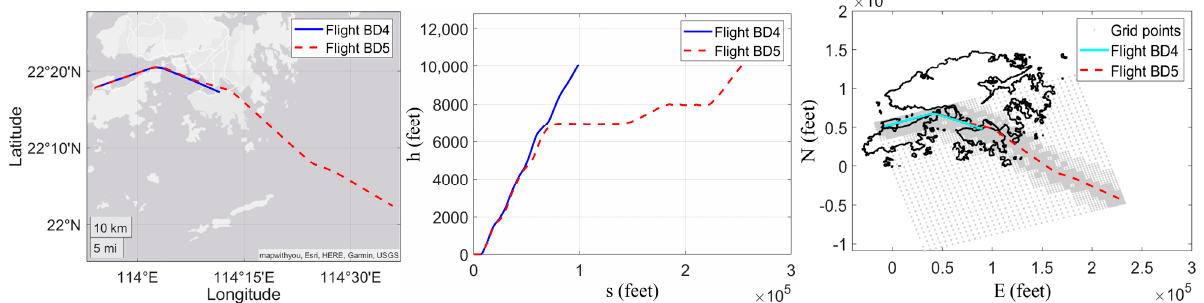
Figure A4. B777 aircraft departing from HKIA. Flights BD4 and BD5 respective routes (left: ground track, center: flight profile) and corresponding ground observers (dynamic grid, right).